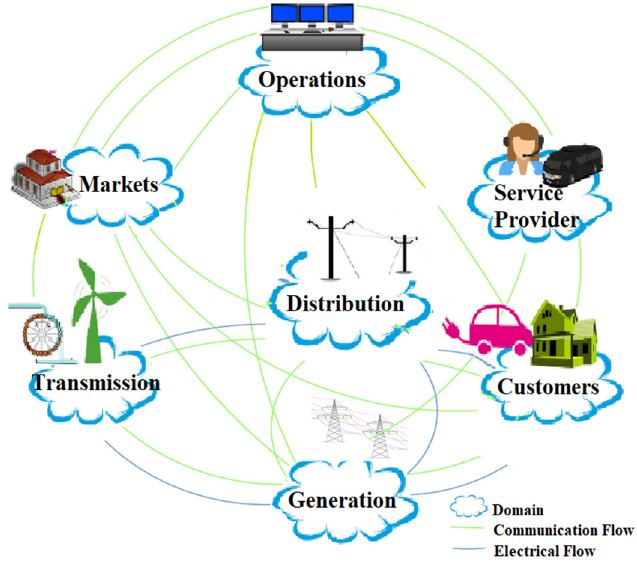
Figure 1. NIST SG Model.